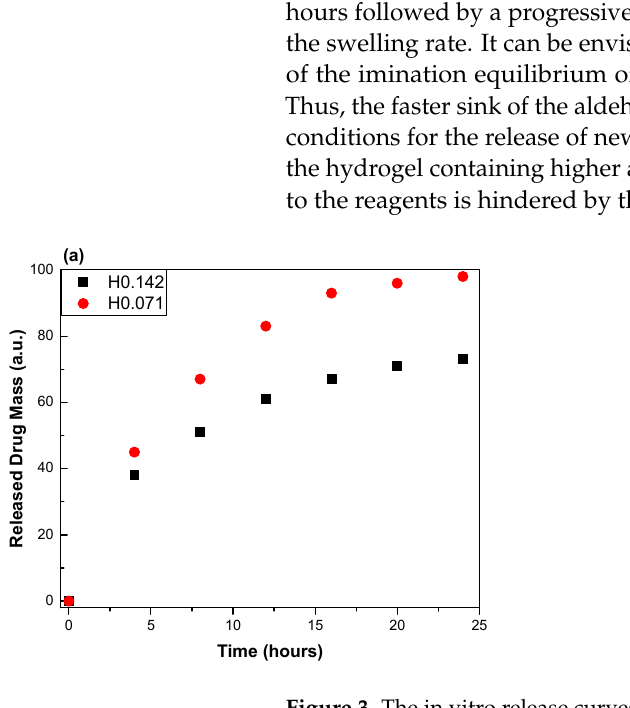
Figure 3. The in vitro release curves of the bioactive aldehyde from chitosan-based hydrogels ( a ) and the multifractal fit of the empirical data ( b ).